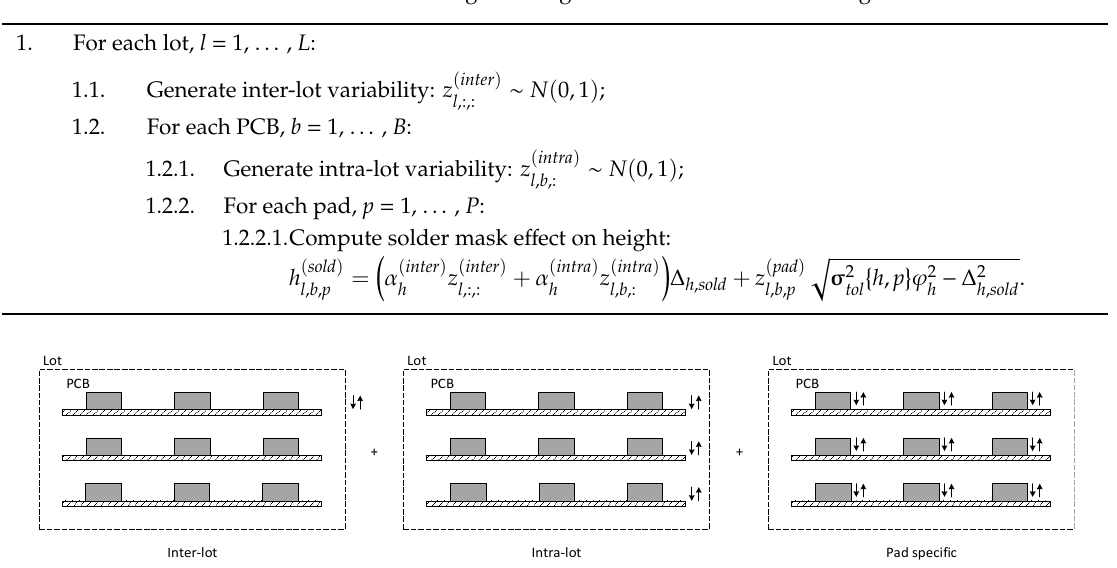
Table 6. Pseudo-code for generating the solder mask effect on height.